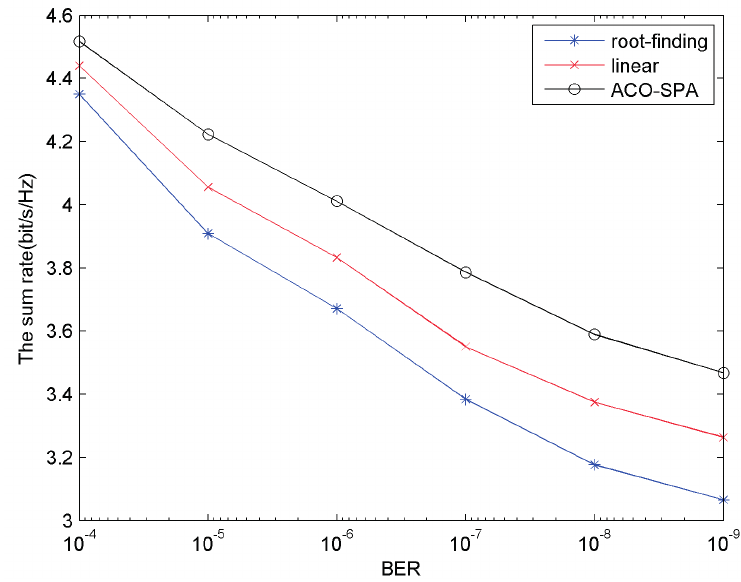
Figure 6. The sum rate versus